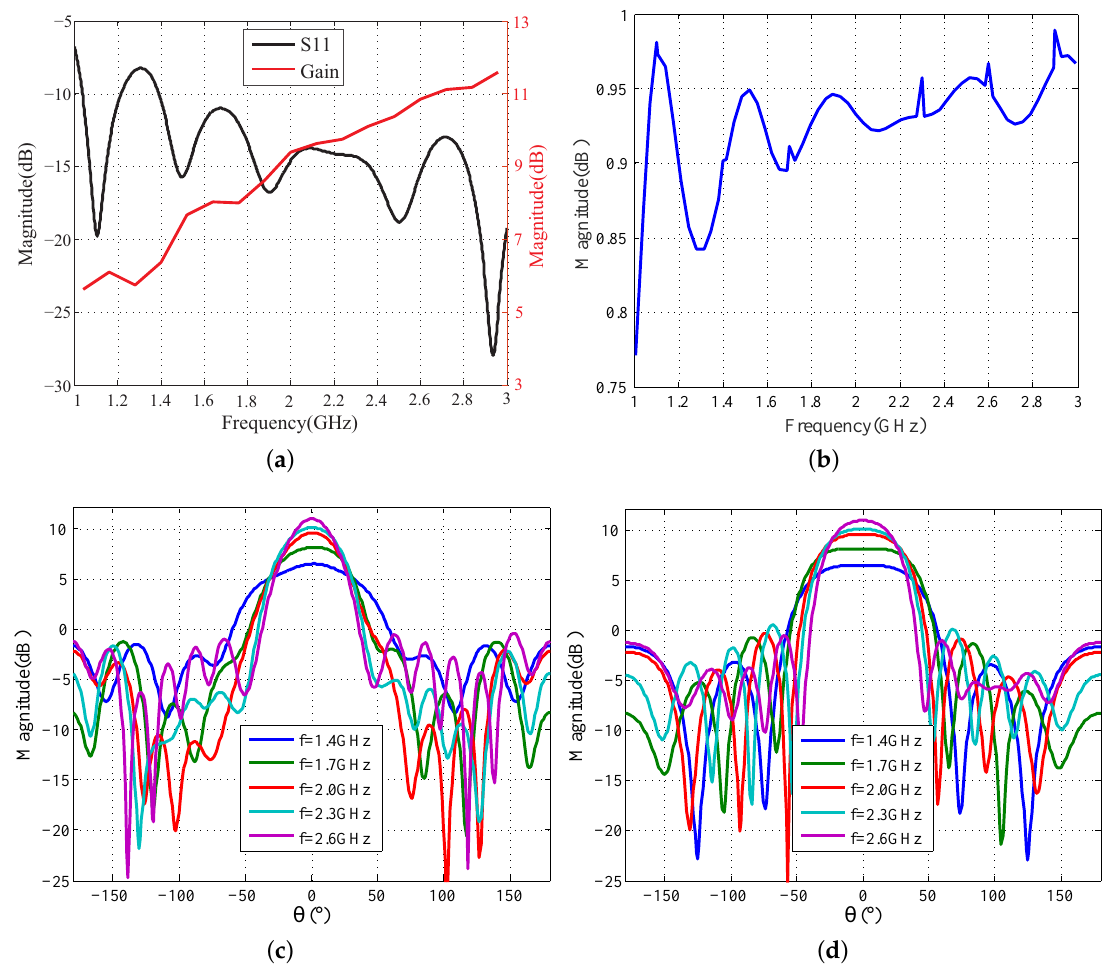
Figure 4. The characteristic curves of the simulated Vivaldi antenna: ( a ) Return loss and gain; ( b ) Radiation efficiency; ( c ) Beam pattern of the E plane; ( d ) Beam pattern of the H